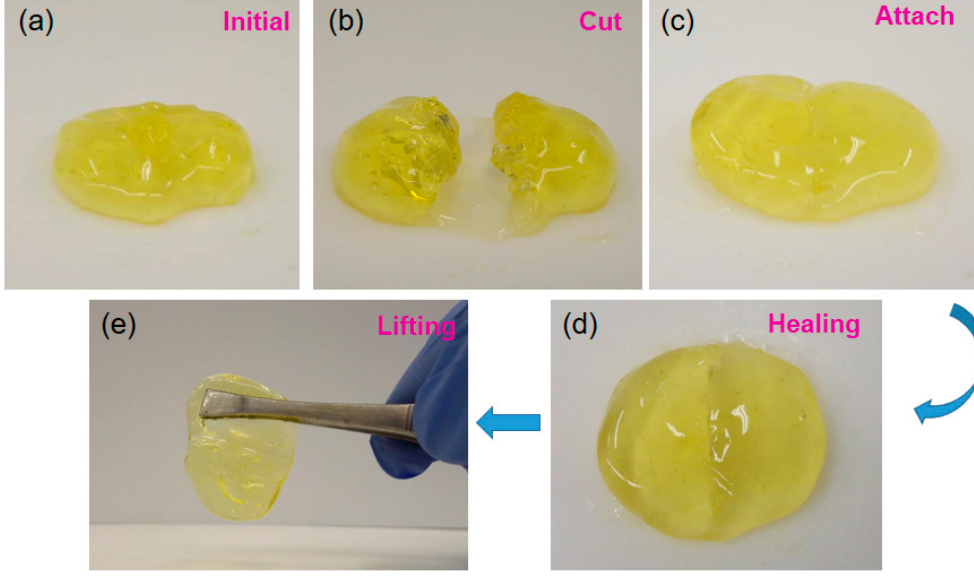
Figure 4. ( a – e ) The optical self-healing process of MA-UPy-PEO-UPy-MA supramolecular hydrogel.